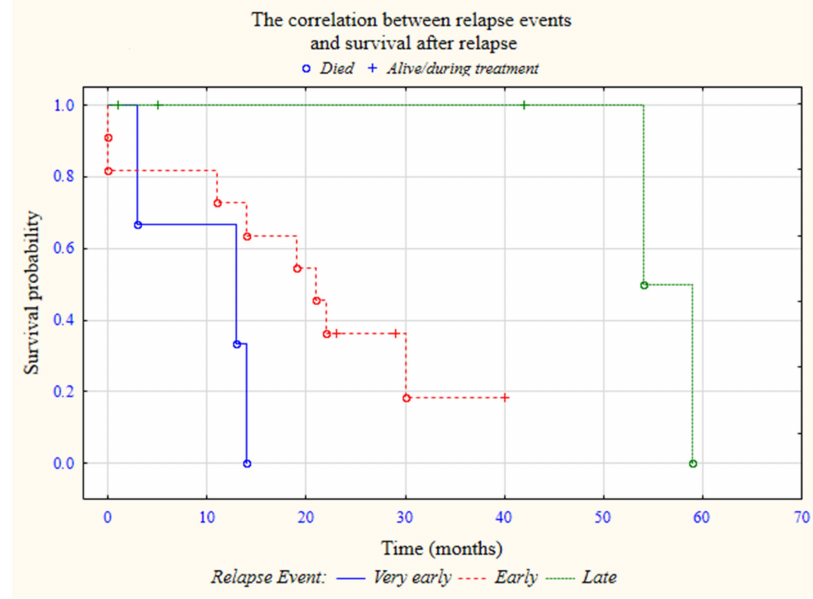
Figure 1. The correlation between relapse events and survival after